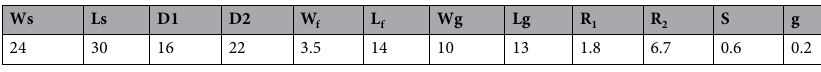
Table 1. The dimensions of the single unit UWB antenna.